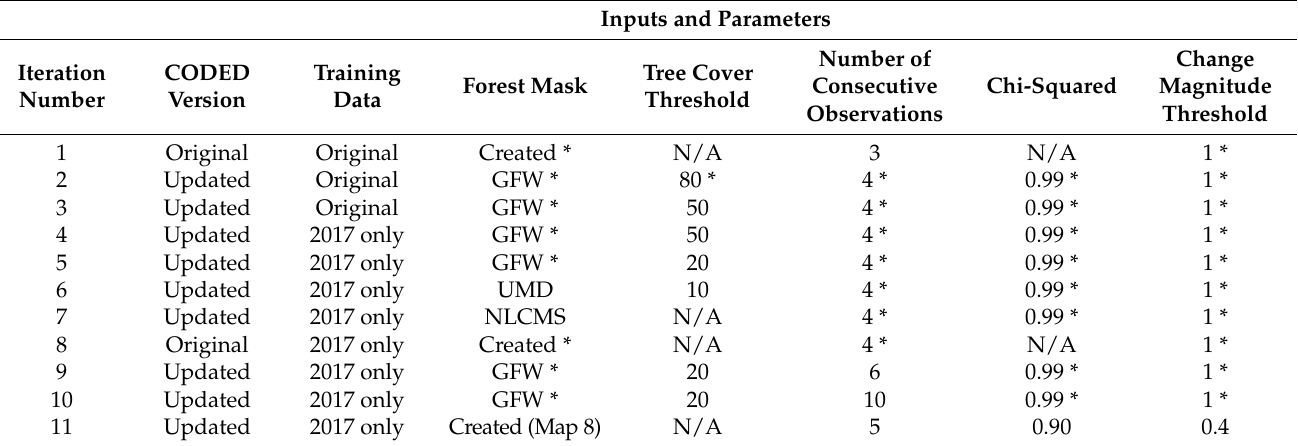
Table 1. History of the parameters adjusted for each model run in our iterative process. Inputs and